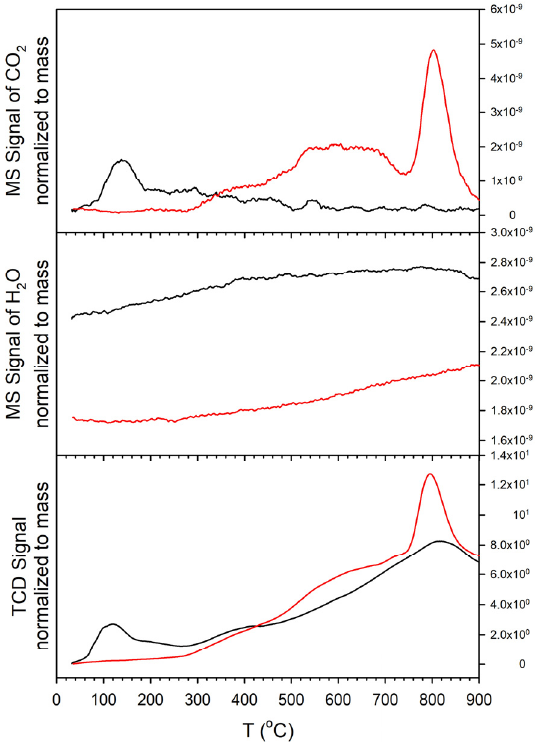
Figure 14. Temperature programmed oxidation after 6 h of time on-stream (in situ DRIFTS) of (black) 2%Pt/m-ZrO 2 and (red) 2.5%Na-2%Pt/m-ZrO 2 , including ( bottom ) TCD signal, ( middle ) H 2 O MS signal, and ( top ) CO 2 MS signal.